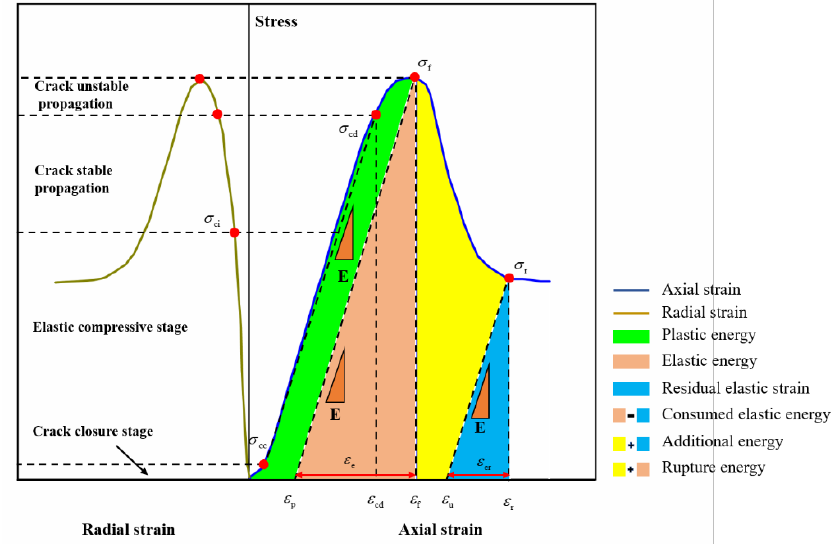
Figure 1. Deformation and failure characteristics and energy evolution of brittle rocks in a typical  is crack initiation stress,  is crack closure stress,  is crack dam- stress – strain curve ( ci cc cd  is strain in crack damage state,  is residual stress, age stress, f  is failure stress, cd r  is failure strain,  is residual strain,  is elastic strain,  is elastic strain at residual f r e er state, and E is Young’s